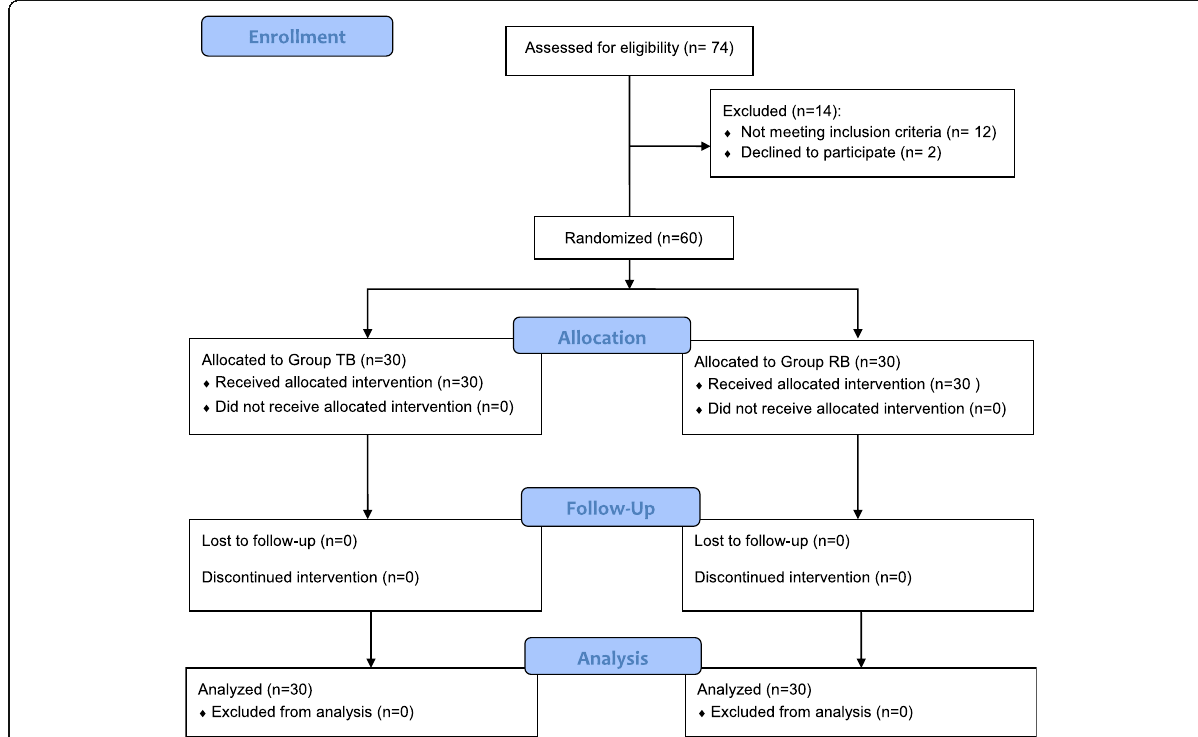
Fig. 1 Consort flow chart for the studied cases. TB transversus abdominis plane block, RB Rectus sheath